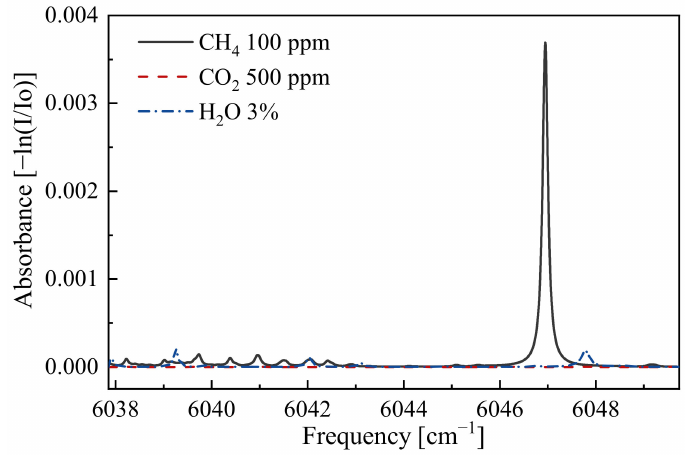
Figure 1. Absorption spectra of CH 4 , CO 2 , and H 2 O based on HITRAN database.